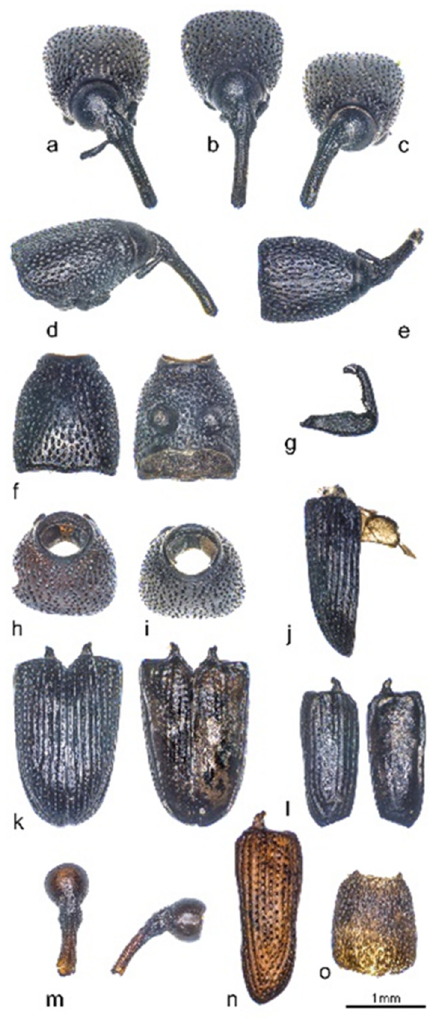
Figure 7. Selection of skeletal elements from Sitophilus granaries ; ( a – e ) well 990, head and pronotum; ( f ) well 990, pronotum; ( g ) well 250, extremity; ( h ) well 994, pronotum; ( i ) well 990, pronotum; ( j ) well 990, elytron; ( k ) well 994, elytra; ( l ) well 250, elytron; ( m ) well 994, head and pronotum; ( n ) well 994, elytron; and ( o ) well 994, pronotum. Photographs: Raül Soteras.